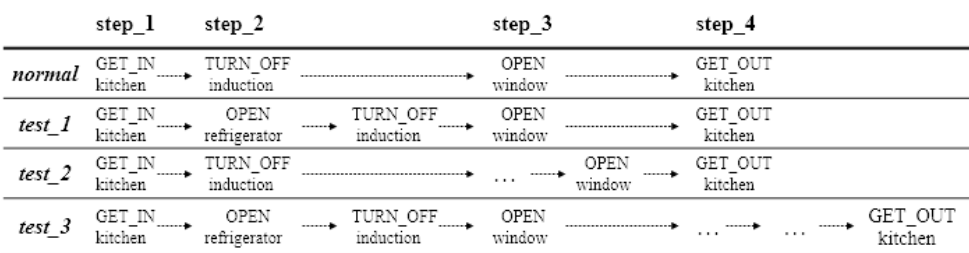
Figure 16. Test performance scenario mixed with several abnormal behaviors.